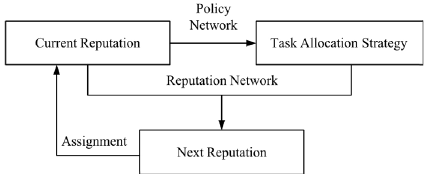
Figure 3. The iteration between the policy network and the reputation